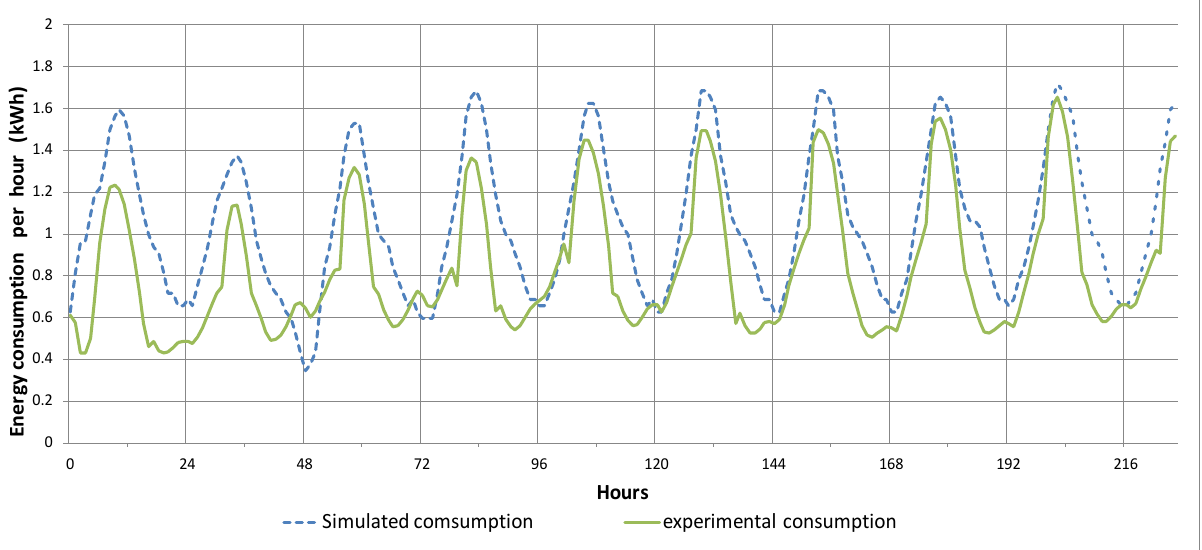
Figure 9. Measured vs. predicted thermal consumptions per hour in the heat